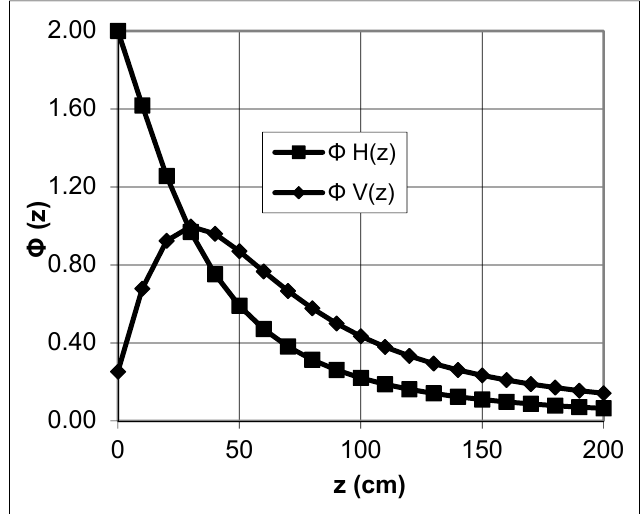
Figure 4. Comparison of calculated relative responses for vertical ( Φ V(z)) and horizontal( Φ H(z)) oriented dipoles.